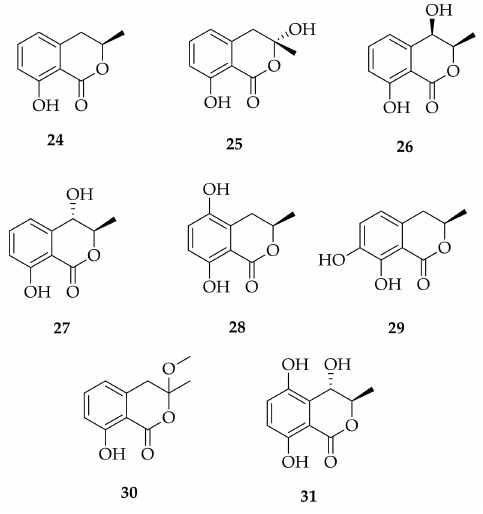
Figure 4. Structures of melleins: ( R )-( − )-mellein, ( R )-( − )-3-hydroxymellein, (3 R ,4 R )- ( − )-4-hydroxymellein, (3 R ,4 S )-( − )-4-hydroxymellein, (3 R )-5-hydroxymellein, 7-hydroxymellein, ( ± )-botryoisocoumarin A, (+)-neoisocoumarin ( 24 – 31